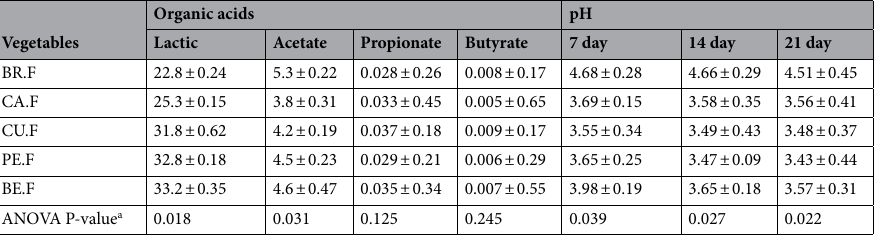
Table 3. Content of organic acids (g kg −1 ) and pH of fermented vegetables. Number of repetitions (n = 4). a P < 0.05 statistical differences.